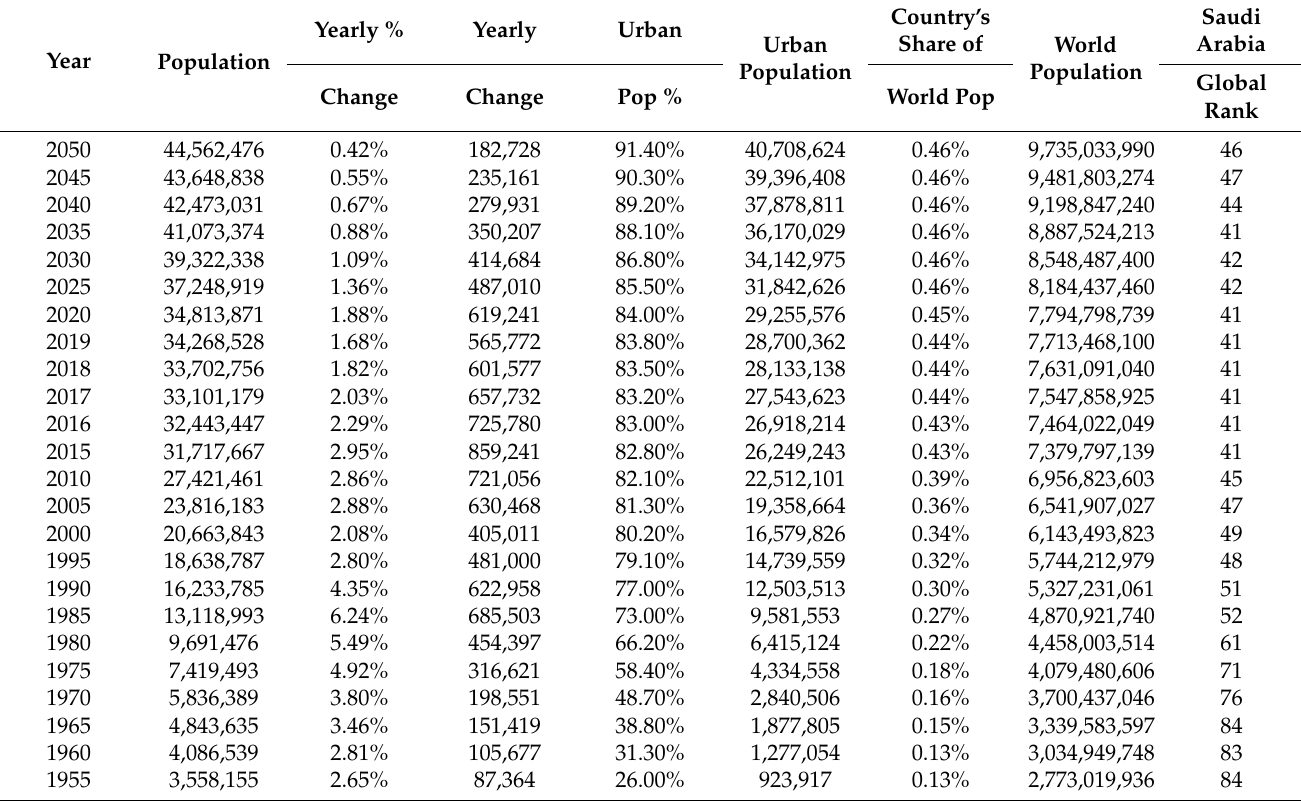
Table A1. Population prediction in Saudi Arabia (1955–2050).